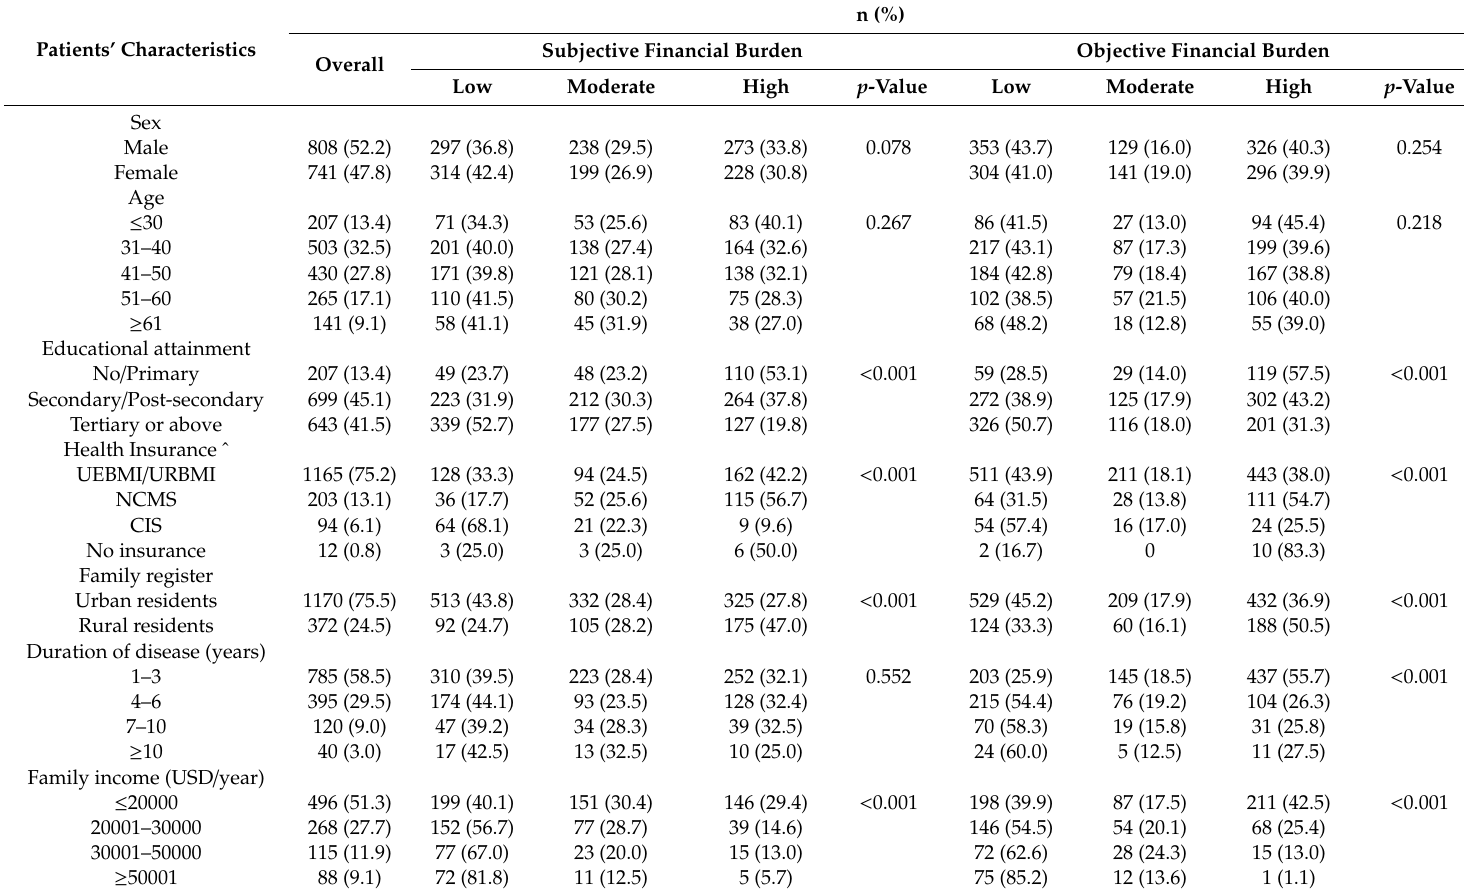
Table 1. Degree to financial burden by patients’ characteristics ( n =